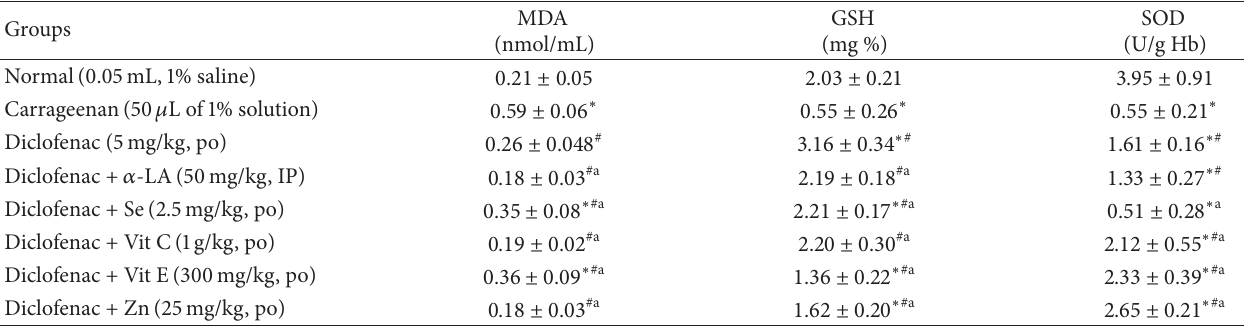
Table 4: Effects of combination treatments of diclofenac and the test antioxidants on plasma levels of MDA, hemolysate GSH, and erythrocyte SOD activity in a rat carrageenan-induced paw edema